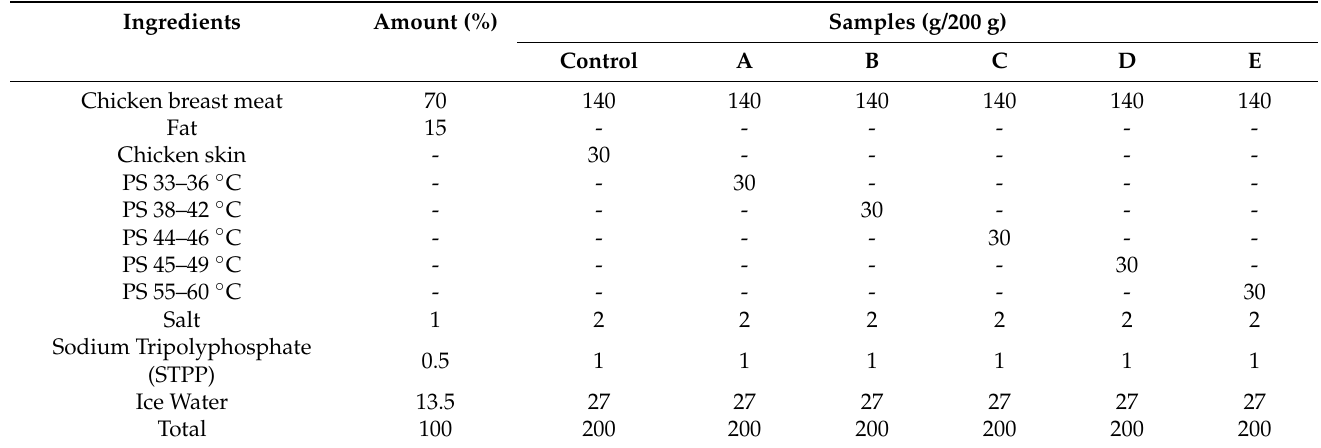
Table 1. Formulations of the fat-replaced meat emulsion samples with palm shortenings (PS) of various melting ranges (MR) as compared to the control with chicken